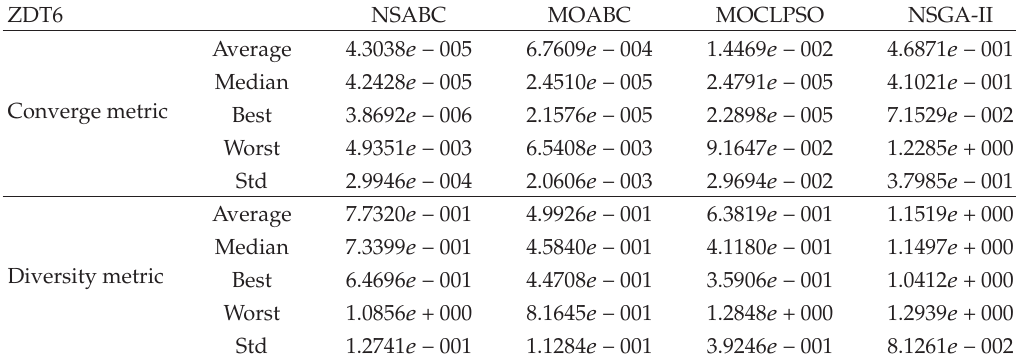
Table 14: Comparison of performance on ZDT6 after 20000 FEs.